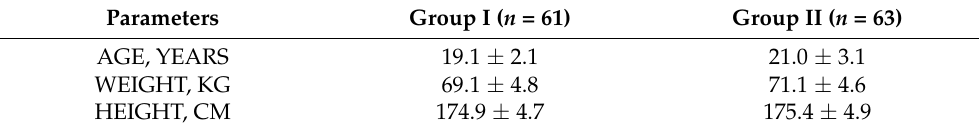
Table 1. Characteristics of the subjects by group, ME ± SD.